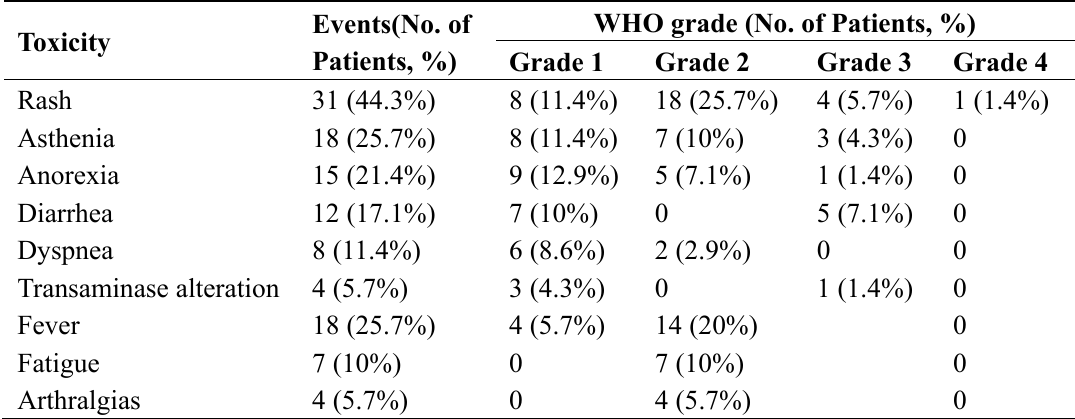
Table 3. Overall population